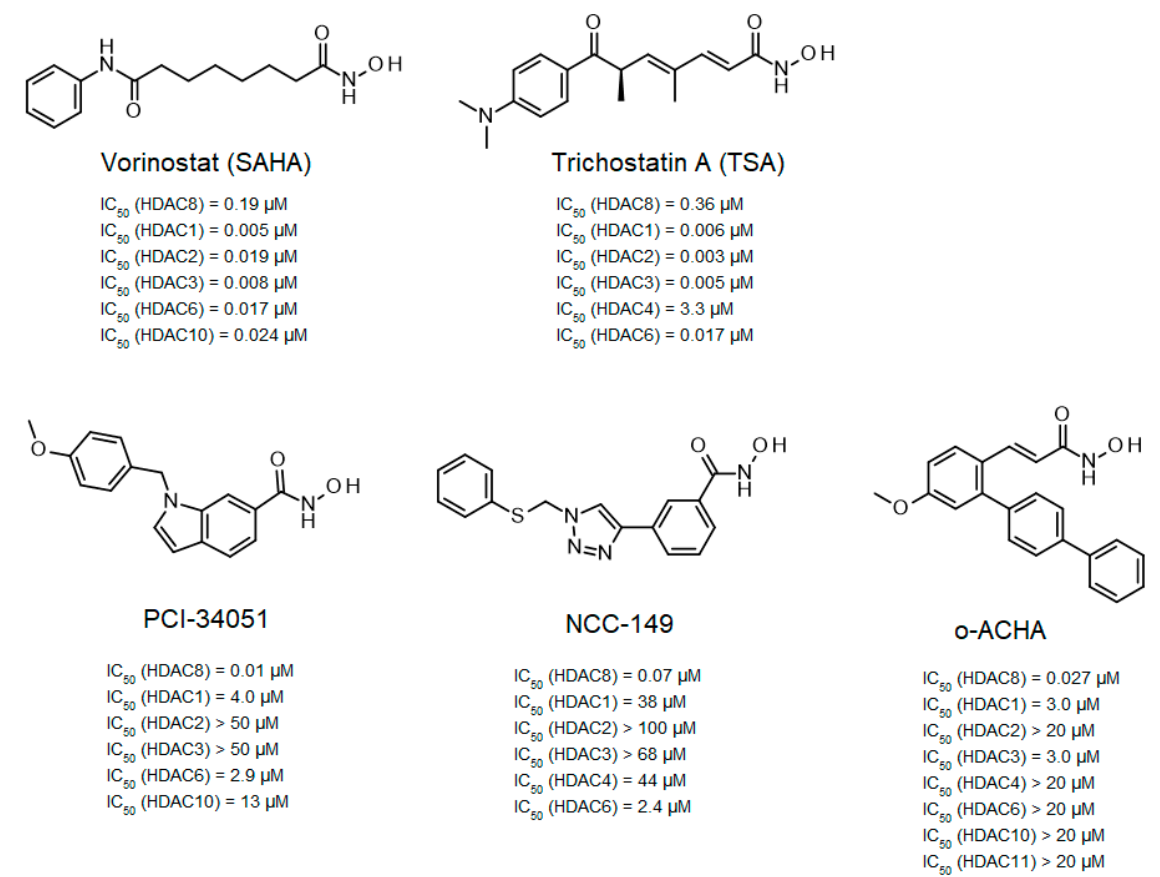
Figure 1. Structures of linear and L-shaped HDAC inhibitors used in this study. IC 50 -values of SAHA and PCI-34051 are from Balasubramanian et al. [12] , NCC-149 from Suzuki et al. [13] , and o-ACHA from Huang et al. [14] .